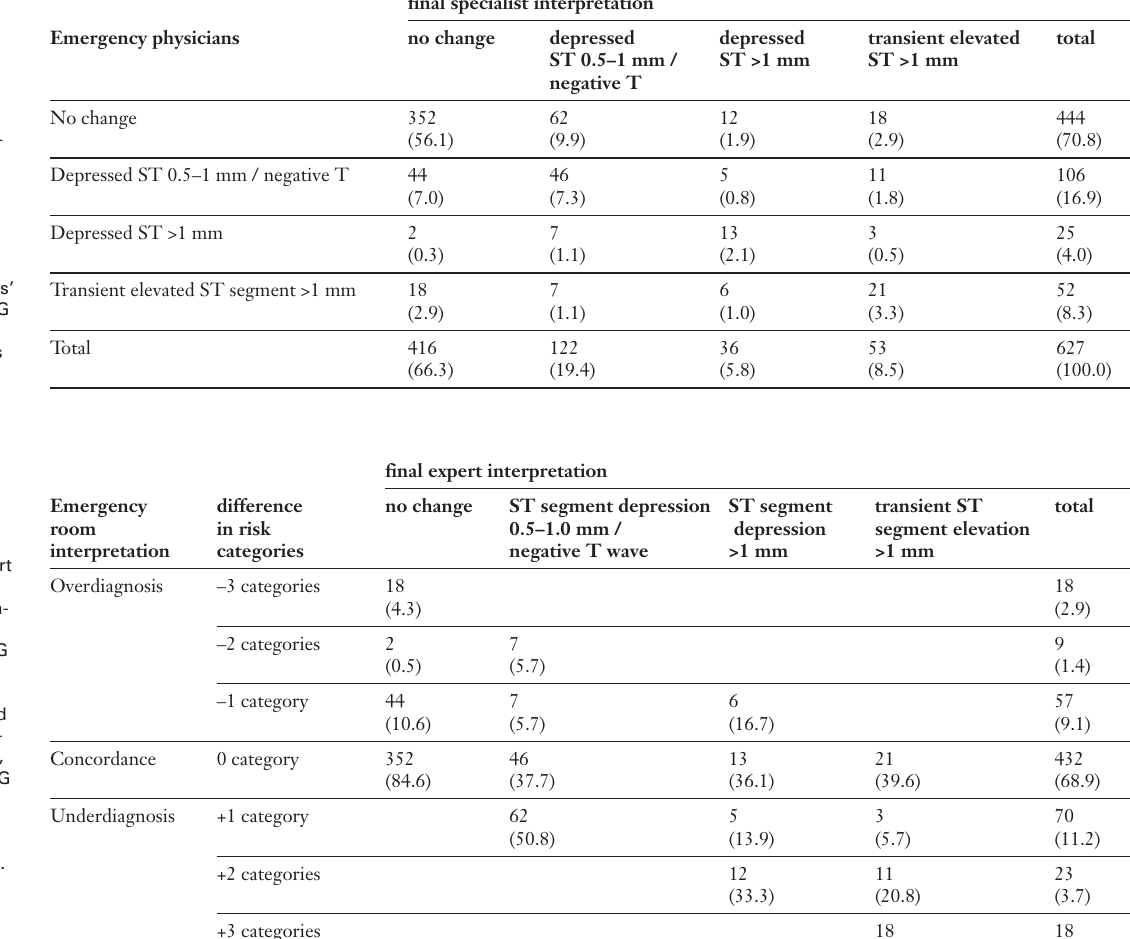
Concordance of ECG interpretation between specialists and emergency physicians (kappa values, n = 627). Concordance was better, if not perfect, between specialists than between emer- gency room physi- cians and specialists.